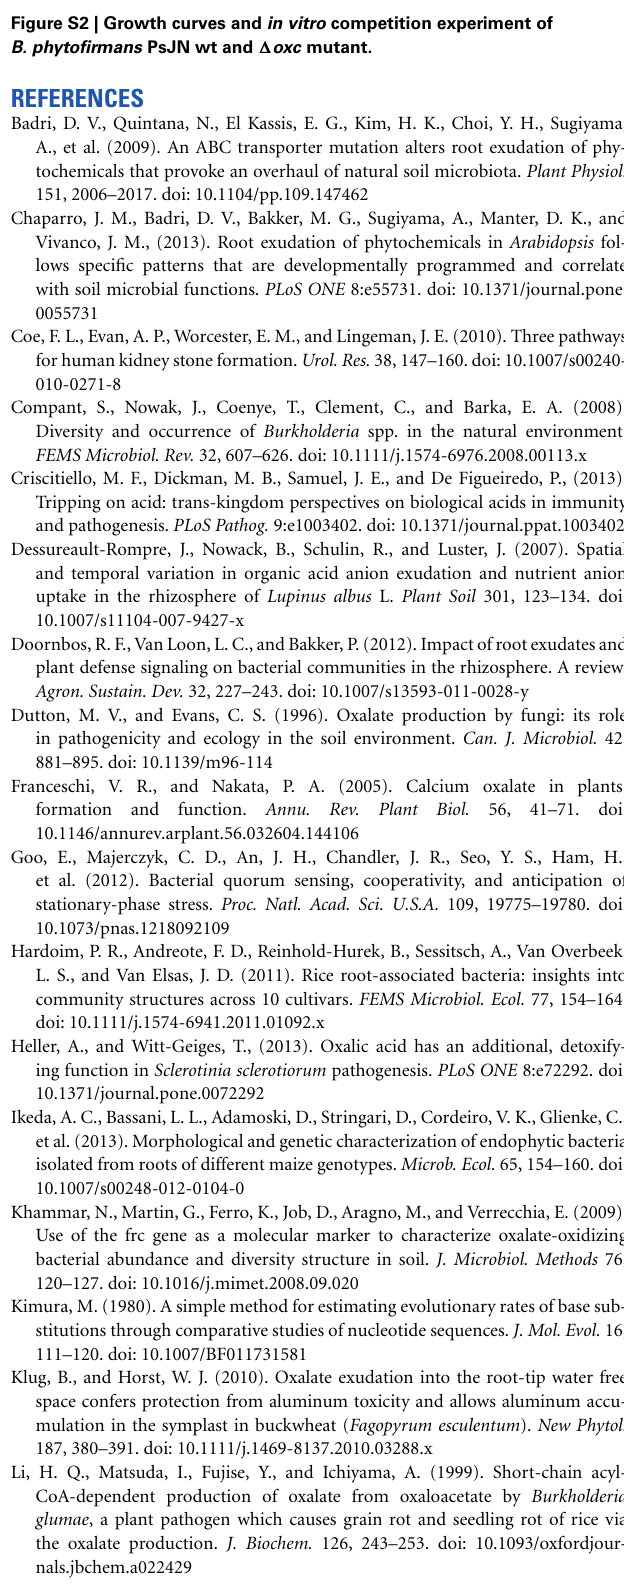
Table S1 | Strains and plasmids used in this study. Figure S1 | Structure of the gene cluster involved in oxalate degradation and construction of a (cid:2) oxc mutant in B. phytofirmans PsJN. Figure S2 | Growth curves and in vitro competition experiment of B. phytofirmans PsJN wt and (cid:2) oxc